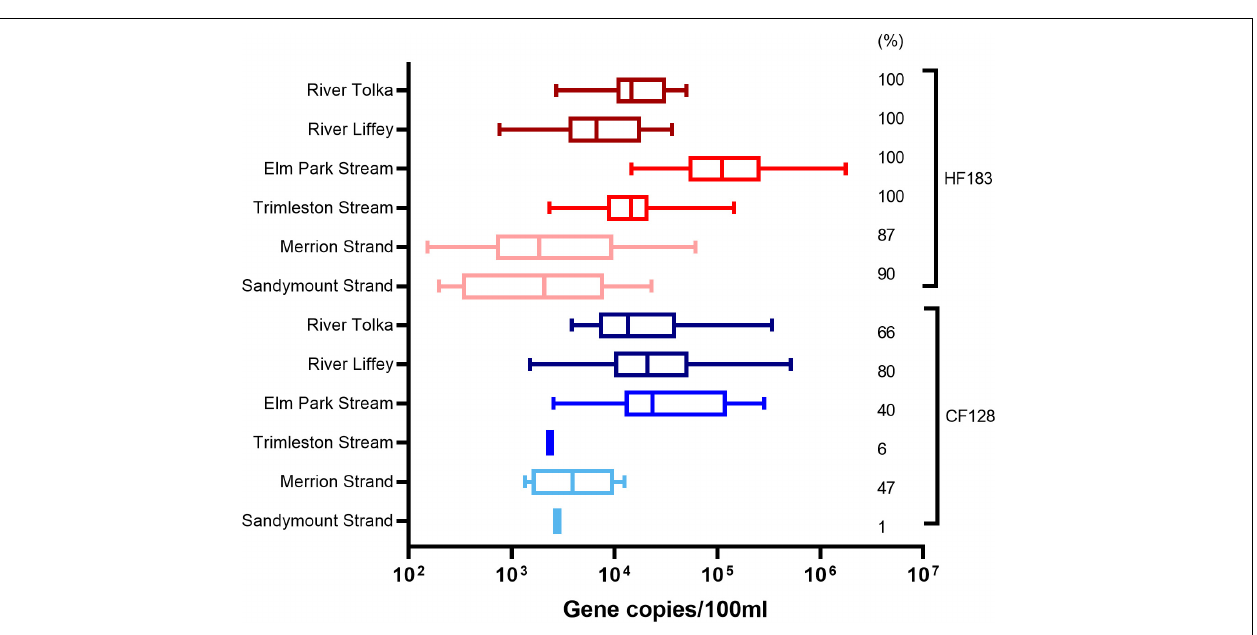
FIGURE 3 | Boxplot representation of the concentrations and percentage of positive samples for the human (HF183) and ruminant (CF128) marker in water samples from rivers (Tolka and Liffey), streams (Elm Park and Trimleston), and bathing waters (Sandymount and Merrion Strands). In the boxplots the lower hinge represents 25% quantile, upper hinge 75% quantile, and center line the median. The whiskers show the maximum and the lowest value. The percentage of samples above the quantification limit is indicated, only values above the quantification limit are